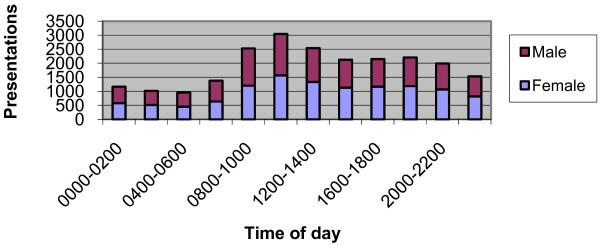
Presentations by Gender and Time of Day.